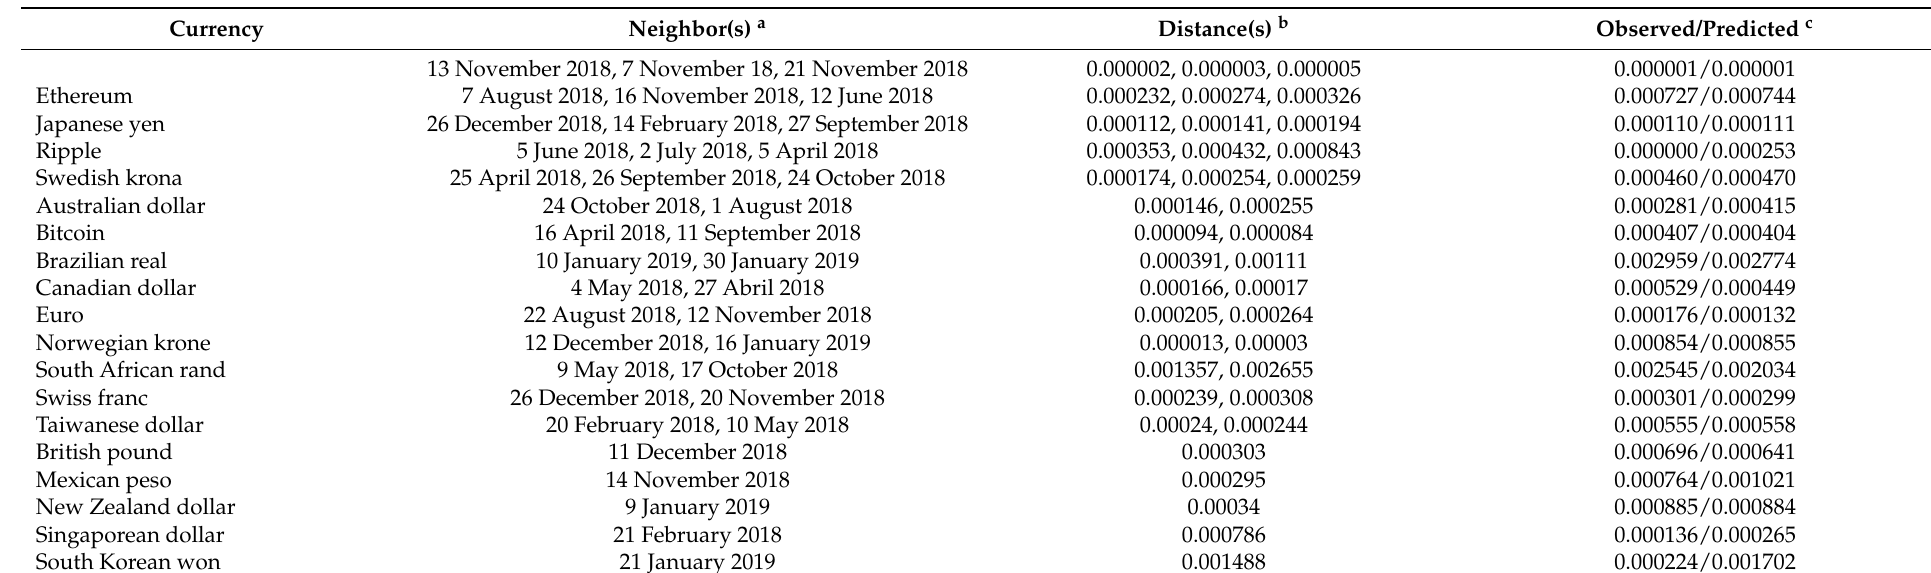
Table 5. Nearest neighbor predictions for 6 February